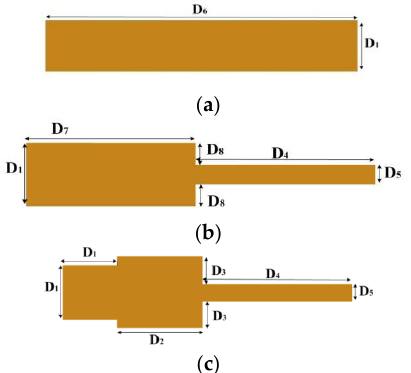
Figure 3. Three types of feeding sheets: ( a ) One transmission line; ( b ) One-step impedance transmission line; ( c ) Two-step impedance transmission line. line; ( c ) Two-step impedance transmission Table 1. Dimensions of the feeding sheets (mm).